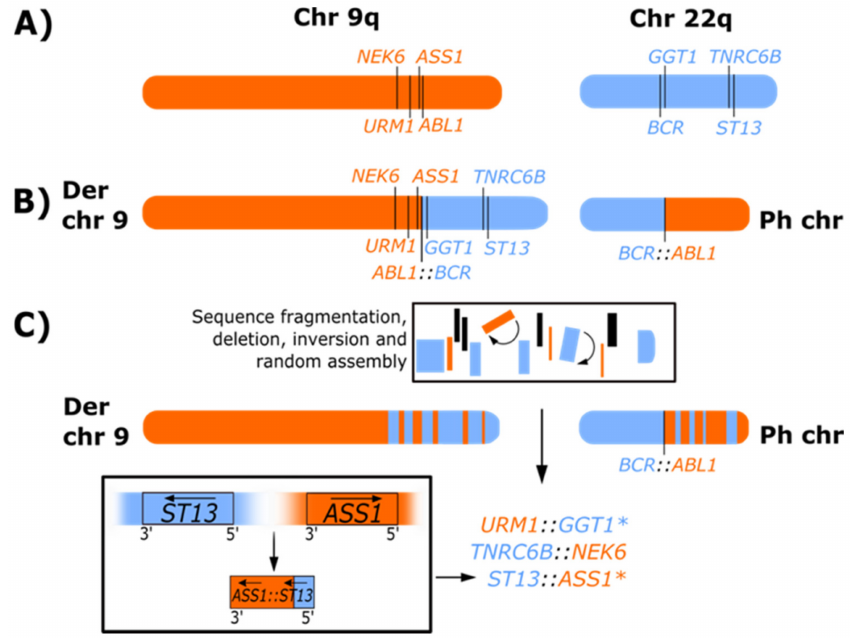
Figure 3. Representation of Ph-associated rearrangements formed as a result of chromoplexy-like events. ( A ) Representation of the q arms of normal chromosomes (chr) 9 and 22. ( B ) Classical Ph chromosome and derivative (Der) chromosome 9 formed by a reciprocal translocation in CML. ( C ) Representation of Ph-associated rearrangements observed for patient 24 of our whole exome sequencing, RNA-seq and copy number variation analysis [11] where multiple novel gene fusions were detected. The location and orientation of the gene fusions suggest that segments of chromosome 9 (orange) and chromosome 22 (blue) fragmented during the formation of the Ph chromosome, which resulted in the loss of genetic material (indicated in black), inversion (indicated by arc arrows and denoted with ( * ), and random reassembly of sequence that generated novel fusions. Using ST13:ASS1 as a model, the fusion was formed following the deletion of sequence adjacent to ST13 on chromosome 22 and ASS1 on chromosome 9, and complex rearrangement involving inversion (denoted with ( * ) and reassembly of sequence that brought the genes into the same transcriptional orientation. The arrows in the lower box indicate the original transcriptional direction of the genes on their respective chromosomes and the transcriptional direction after deletion, inversion, and sequence